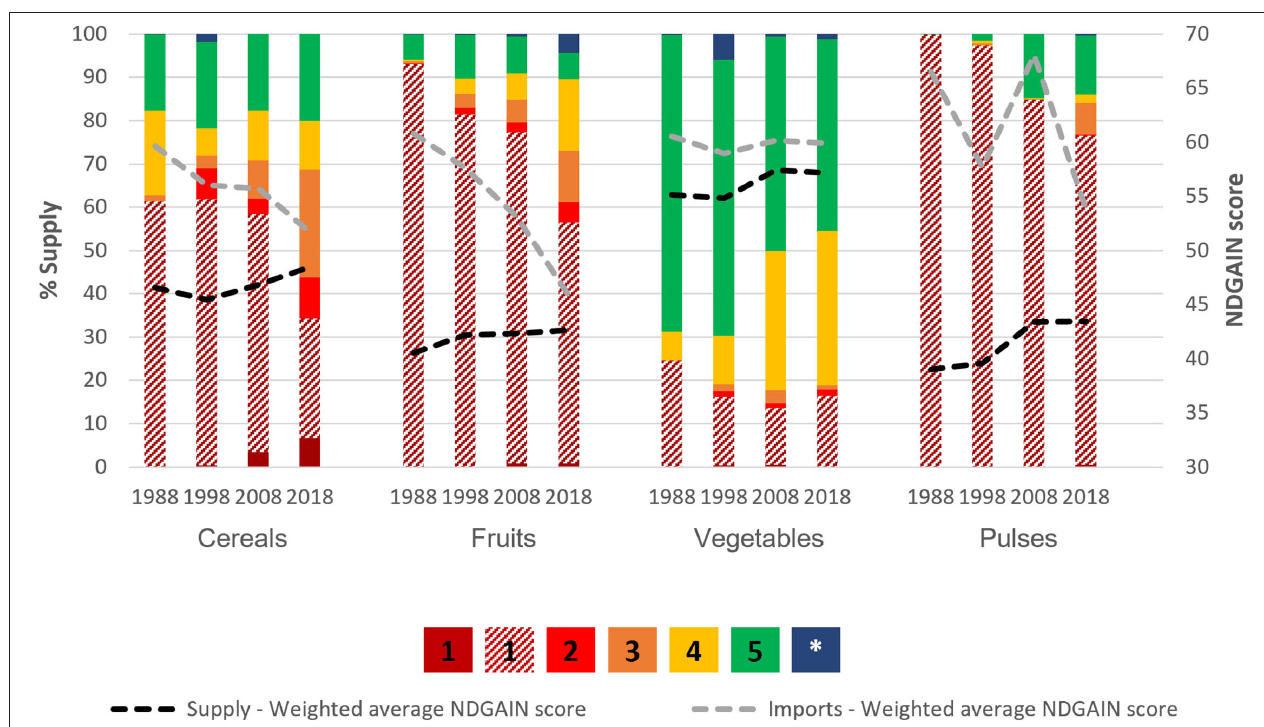
FIGURE 2 | ND-GAIN vulnerability index of country of origin of cereals, fruits, vegetables and pulses supplied to The Gambia . The proportion of supply, within a given crop group and for a given year (1988, 1998, 2008 or 2018), originating in countries characterized by a given climate vulnerability status ([1–dark red] Extreme; [2–red] High; [3–orange] Intermediate to high; [4–yellow] Intermediate; [5–green] Low; or [*-blue] Unknown). Domestic production is shown with diagonal stripes and falls into the Extreme vulnerability (1) category, with the ND-GAIN country index score (2019) of The Gambia being 39.2. This figure also shows the weighted average ND-GAIN score of total supply (black dashed line) and of imports (gray dashed line). All data are 3-year rolling averages. All data between the years of 1988, and 2018 were analyzed, but we present 1988, 1998, 2008, and 2019 as evenly spaced time intervals for figure readability. Data for all years can be found in the supplementary materials ( Supplementary Figure 4 ).